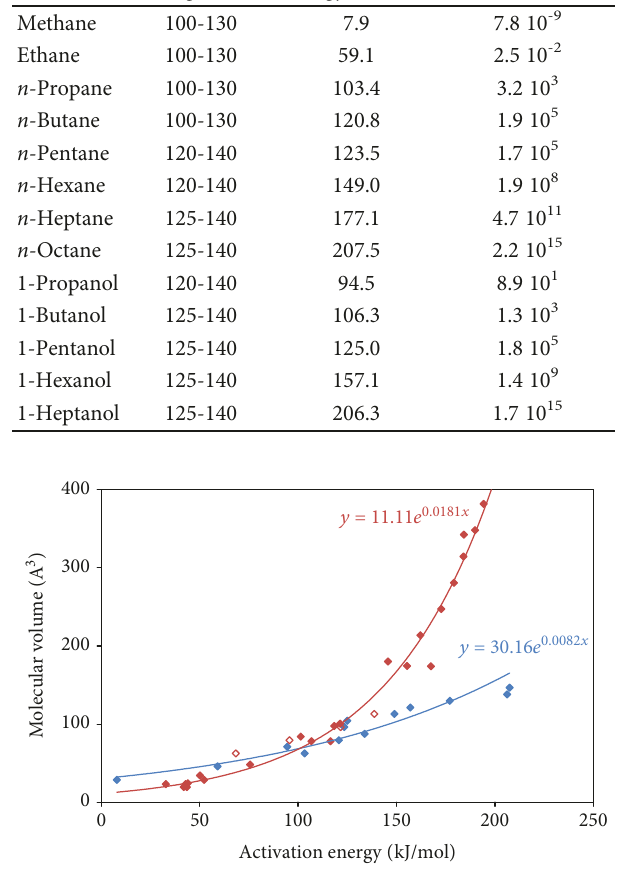
Figure 6: Correlation between the activation energy of di ff usion E and the molecular volume V for PEN (this study, blue dots) and PET (nonsolid red dots from Ref. [10]; solid red dots from Ref.